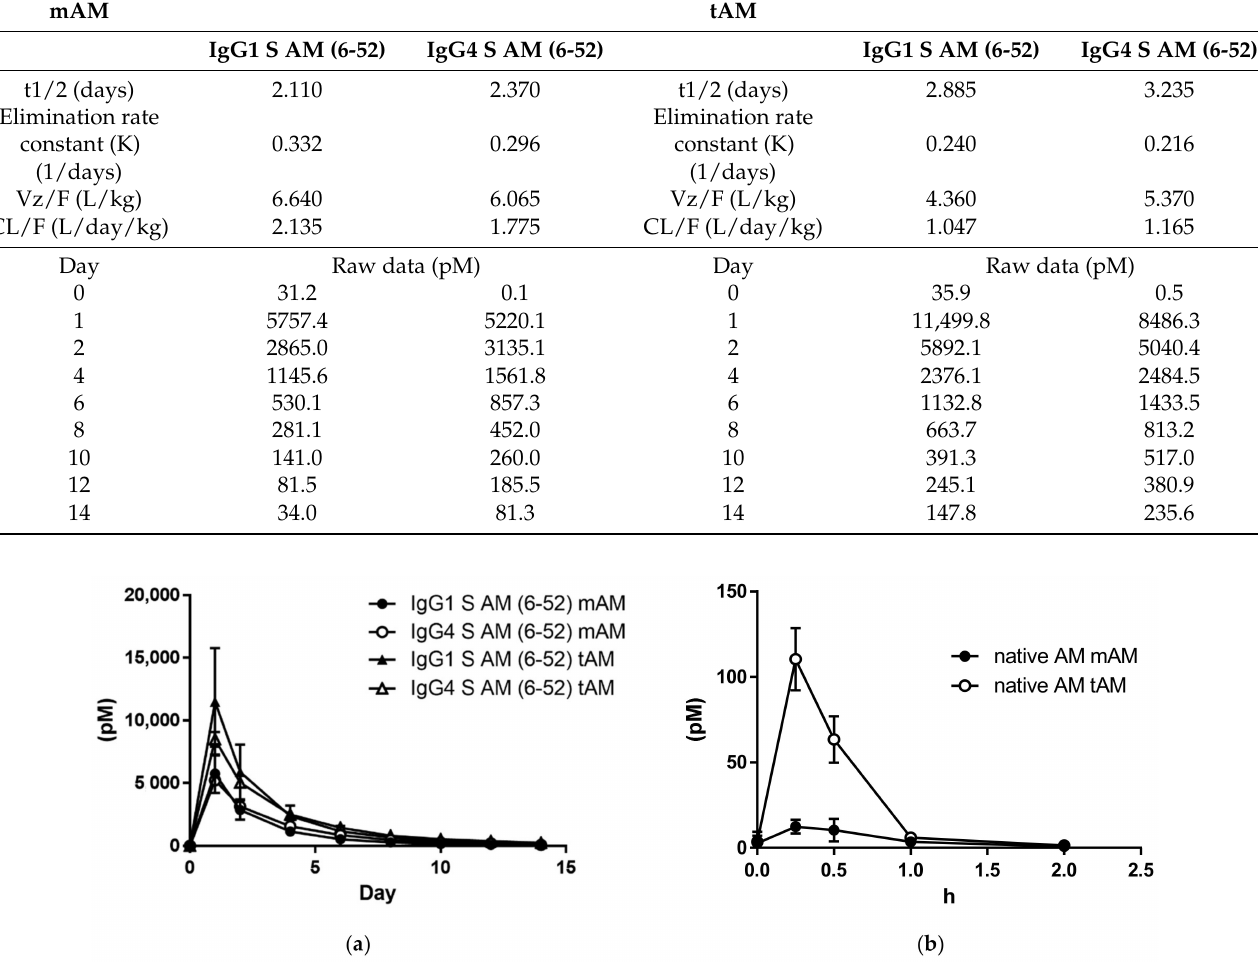
Figure 2. ( a ) Plasma disappearance of IgG1-AM (6-52) and IgG4-AM (6-52) over time. Concentrations of mature AM and total AM in plasma. Anesthetized rats were injected subcutaneously with IgG1-AM (6-52) (30 nmol/kg) and IgG4-AM (6-52) (30 nmol/kg), and blood samples were taken at the indicated time points. ( b ) Plasma disappearance of native AM over time. Native AM was injected subcutaneously into anesthetized rats at a dose of 50 nmol/kg, and blood samples were collected at the indicated time points. Concentrations of mature AM and total AM in plasma.